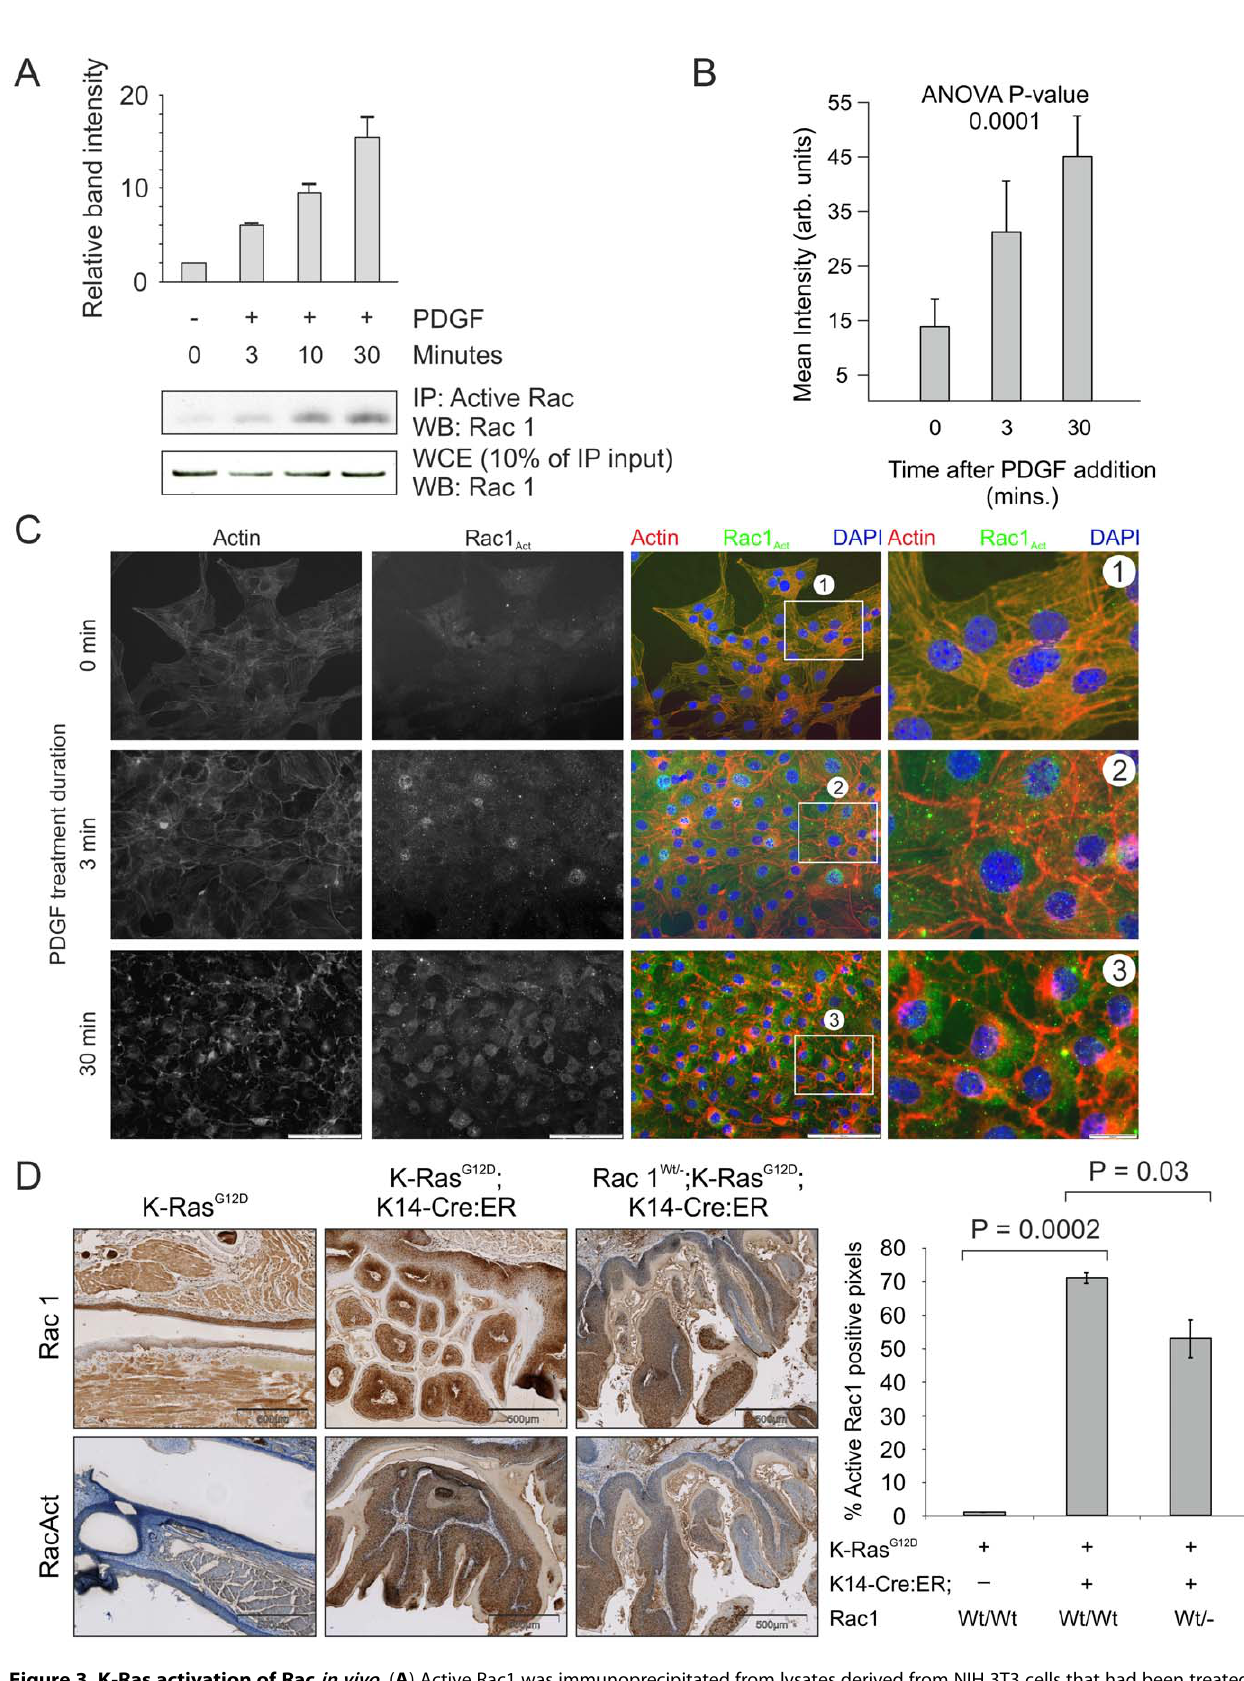
Figure 3. K-Ras activation of Rac invivo . ( A ) Active Rac1 was immunoprecipitated from lysates derived from NIH 3T3 cells that had been treated for the indicated time periods with PDGF (10 ng/ml). Western analysis for Rac1 was carried out on immunoprecipitated protein as well as the original lysate as indicated. ( B ) Histogram showing active Rac1 immunofluorescence intensity averaged over 5 fields of NIH 3T3 cells increasing over the